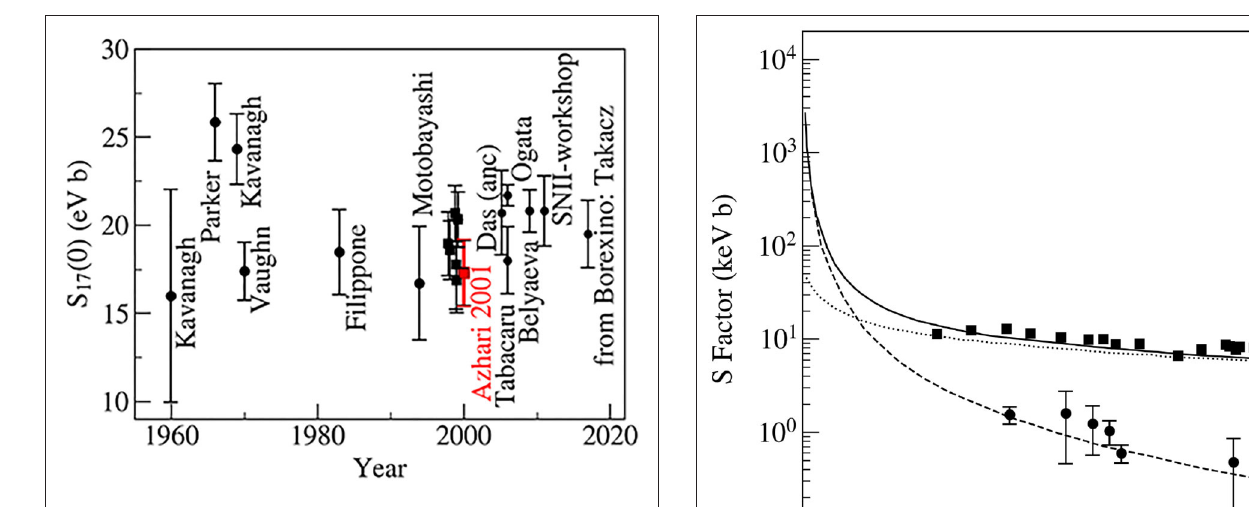
the reaction sequence (Wiescher et al., 1990) 14 C( n , γ ) 15 C( β − ) 15